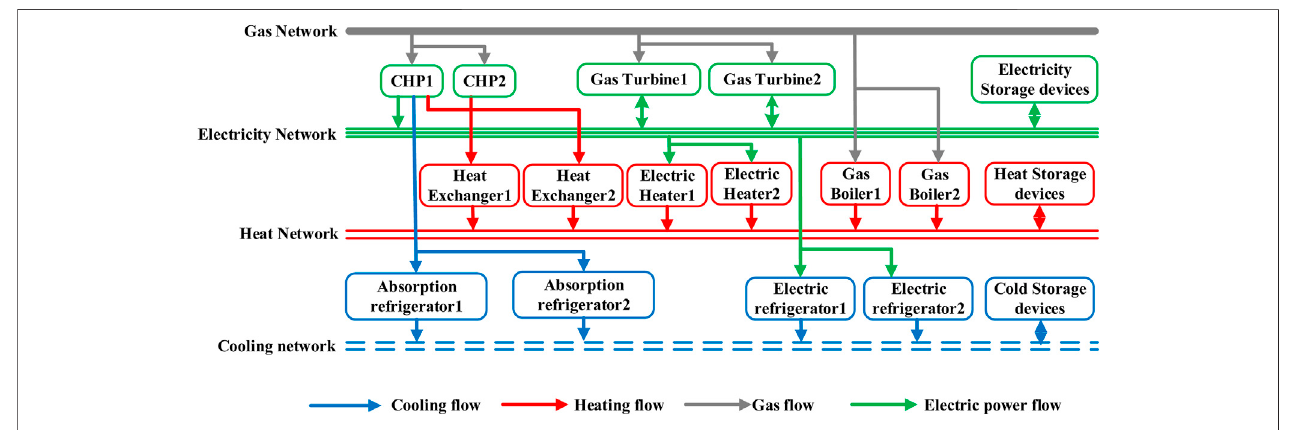
FIGURE 4 | Energy conversions between the conversion devices of the case